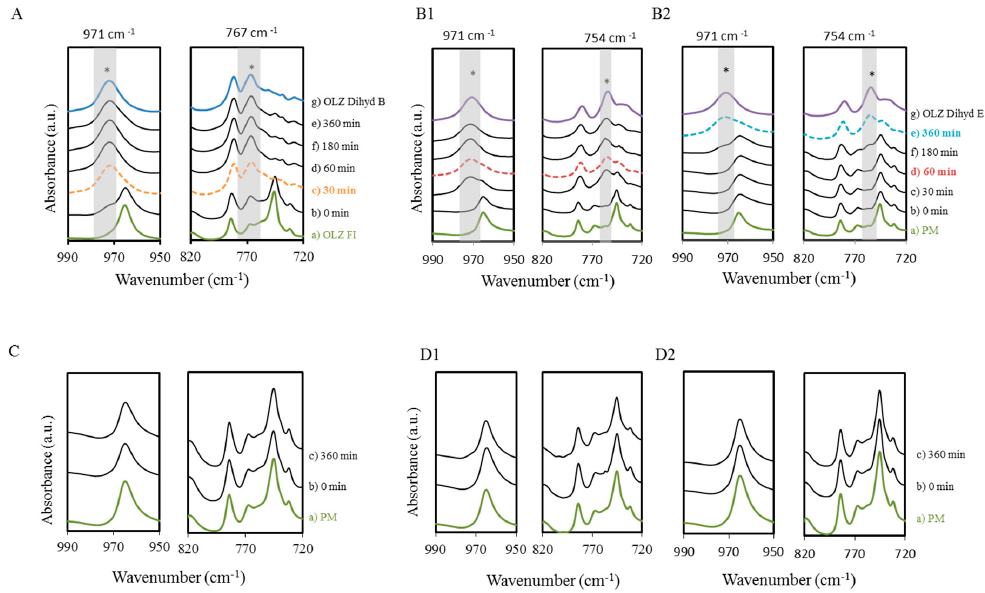
Figure 3. Spectra (FTIR) regions (950–990 cm − 1 and 720–820 cm − 1 ) of OLZ wet masses (1.5 OLZ:1 polymer) after storage in a sealed container. Formulations A ( A ); B 1 ( B1 ) and B 2 ( B2 ) show complete hydration after 30, 60 and 360 min (dashed lines); Formulations C ( C ); D 1 ( D1 ) and D 2 ( D2 ) show no hydration during the time of storage (360 min). (*) Represents the characteristic peaks of the OLZ dihydrate E.